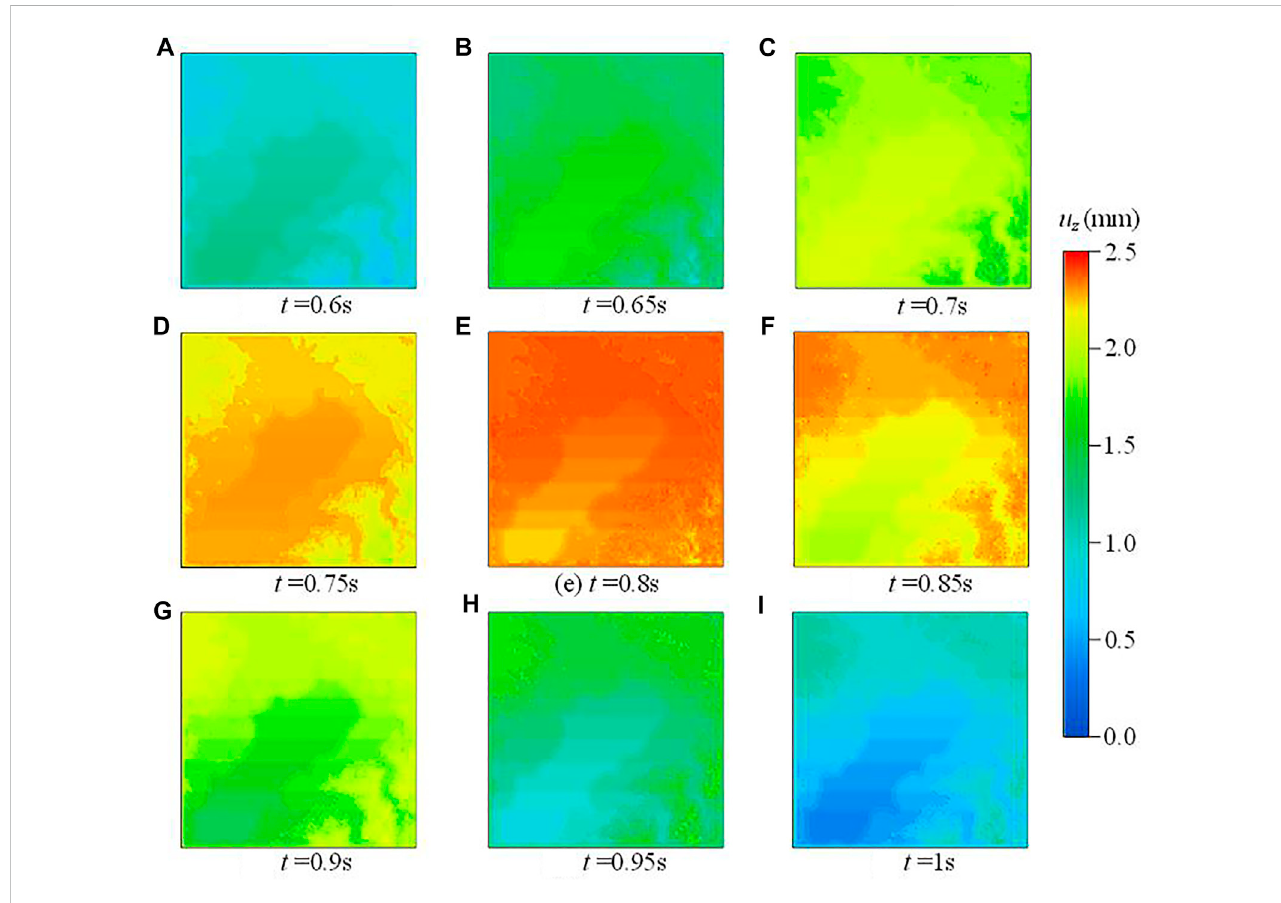
FIGURE 11 The snapshots of the displacement wave fi eld with P-wave